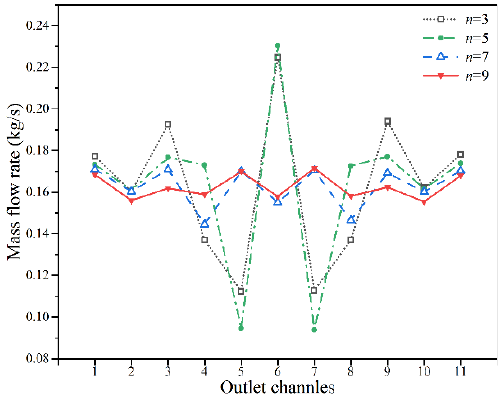
ff erent odd numbers of splitter